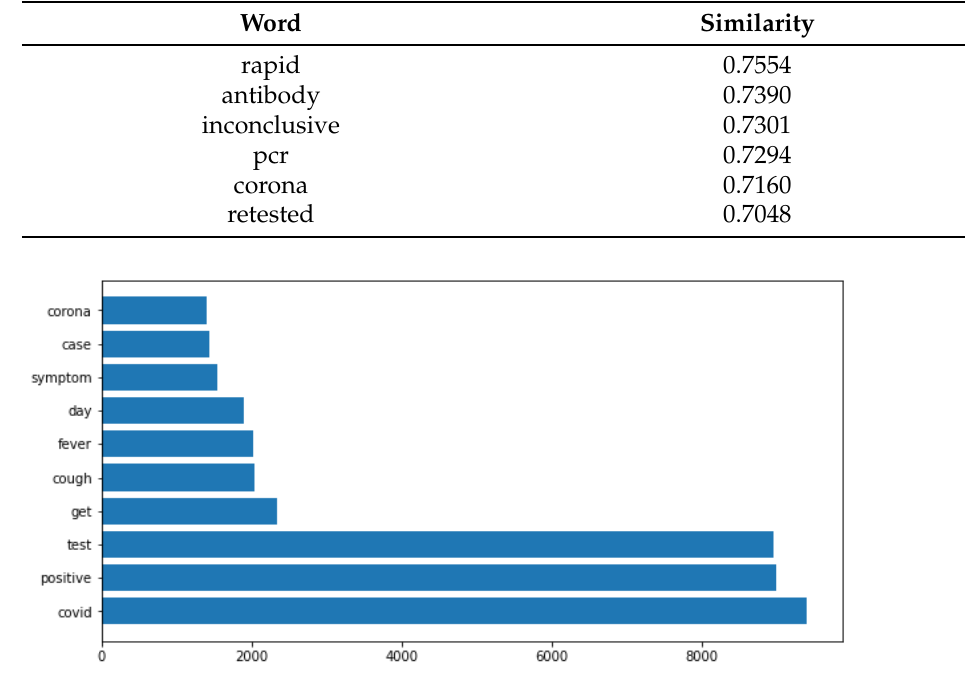
Figure 2. Most frequent words for positive